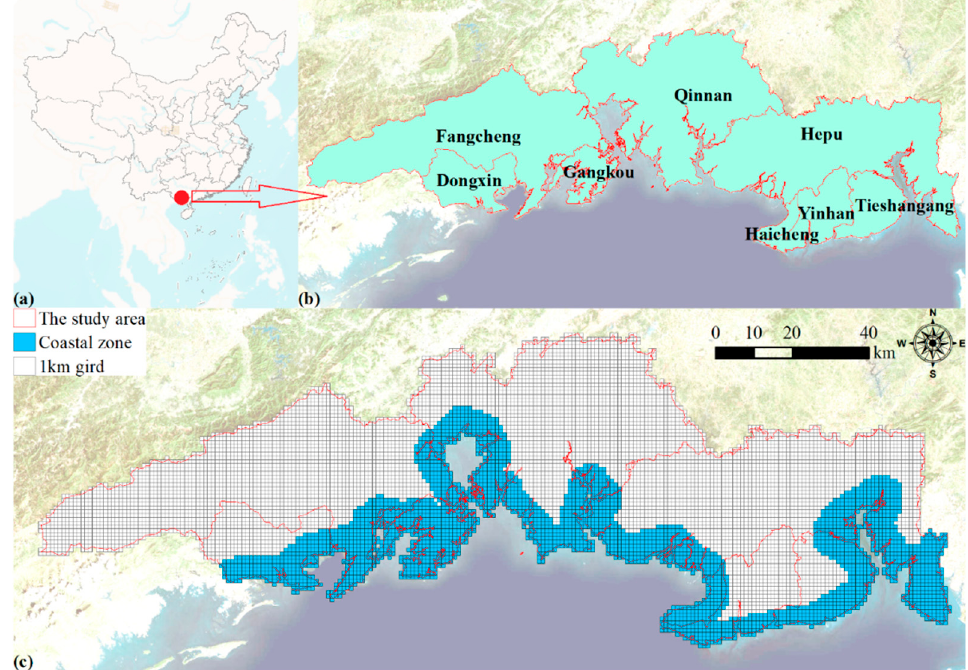
Figure 1. The geographical location ( a ), 8 counties ( b ), 1 km grid and coastal zone ( c ) in the study area.